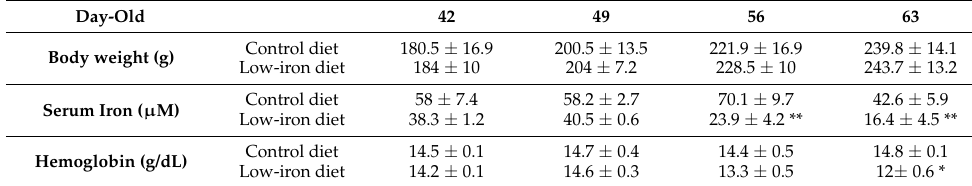
Table 1. Mothers’ body weights, serum iron, and hemoglobin concentrations after taking control or low-iron diet (from 42 d/o) (N = 6 in each group). Day-Old